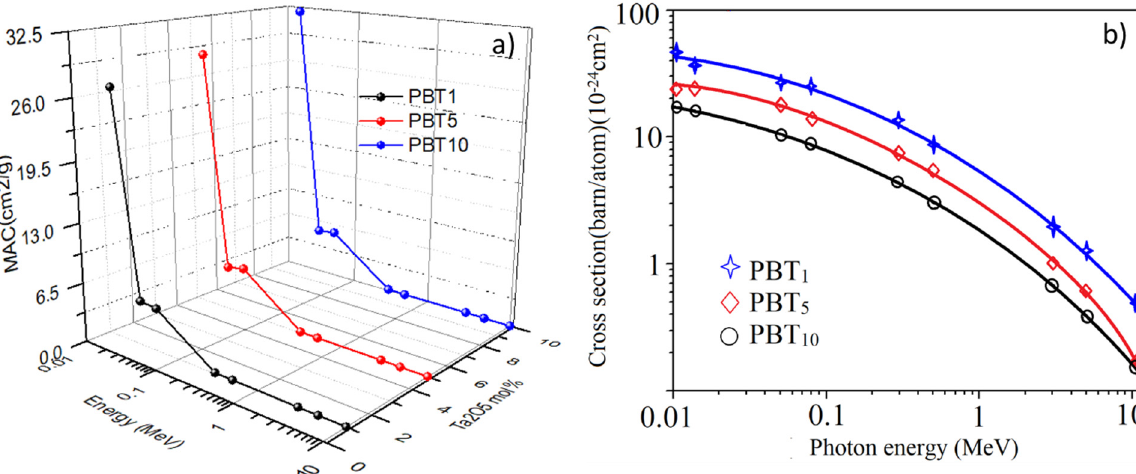
Figure 8. Variation of the MAC ( a ) and CS cross-section ( b ) of the fabricated glasses versus the gamma ray energy. Curves in